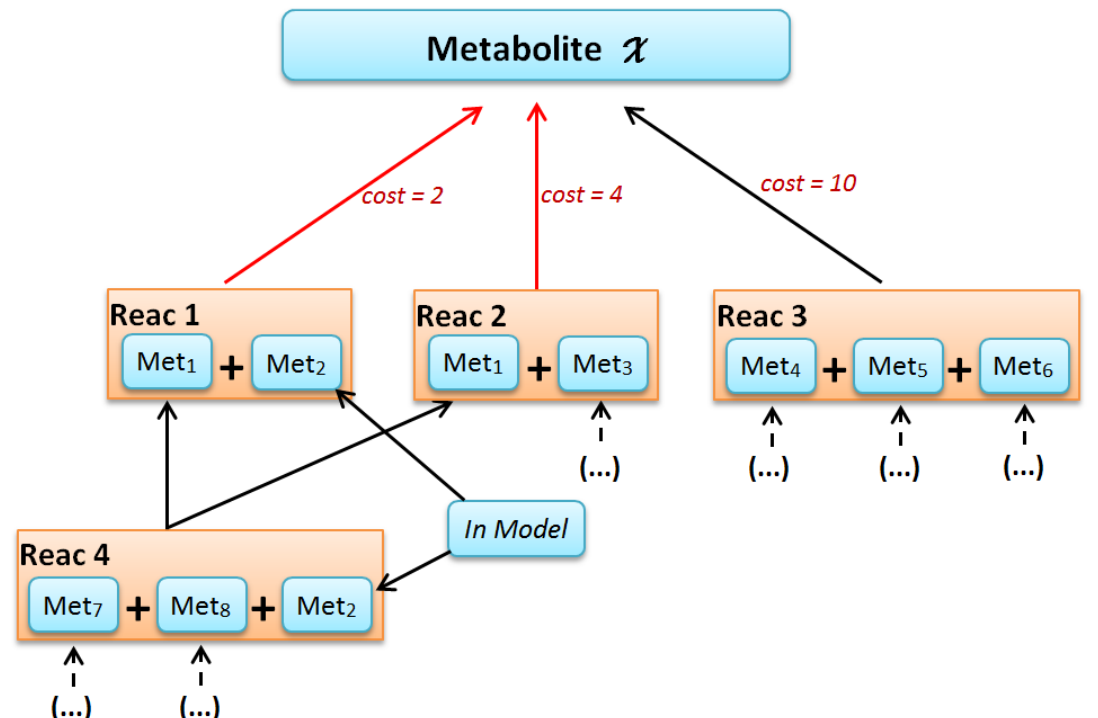
Figure 3: This scheme represents the reactions that will be chosen for the metabolite X production. In this example we can observe that the metabolite x can be produced through the reactions: Reac1, Reac2 and Reac3, with costs 2, 4 and 10 respectively. If the user chooses 30% for tolerance value, only the reactions Reac1 and Reac2 will be inserted in the database. This process is repeated for all metabolites from reactions Reac1 and Reac2. Note that the Met2 is already in the original metabolic